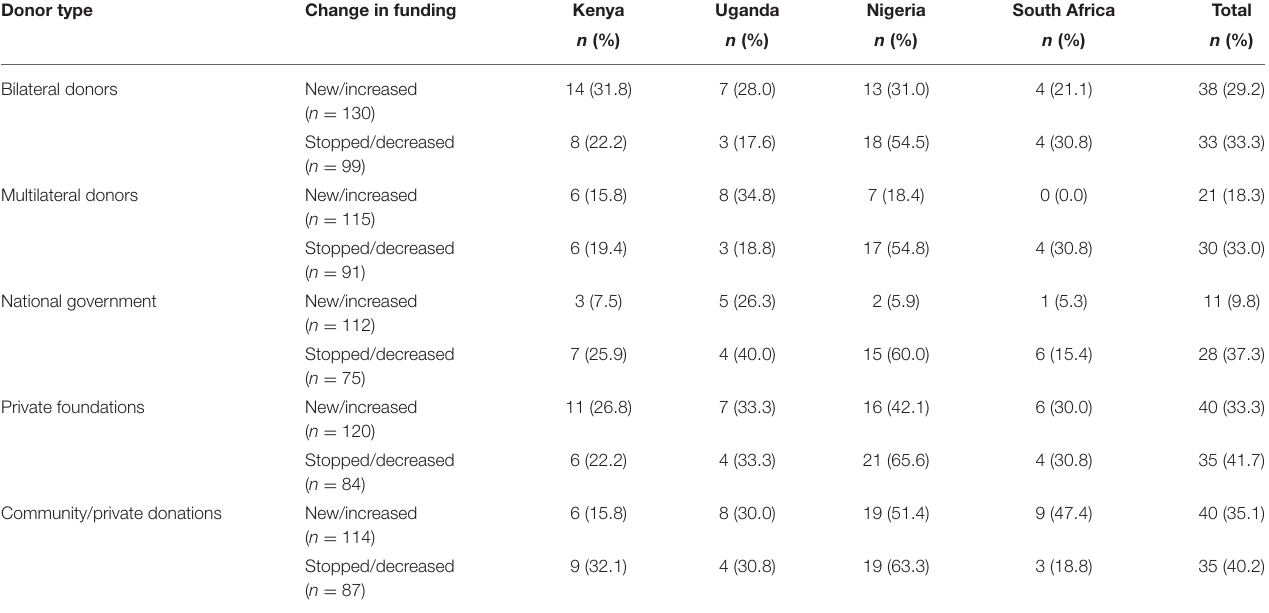
TABLE 5 | Changes in donor funding to respondents’ organizations during